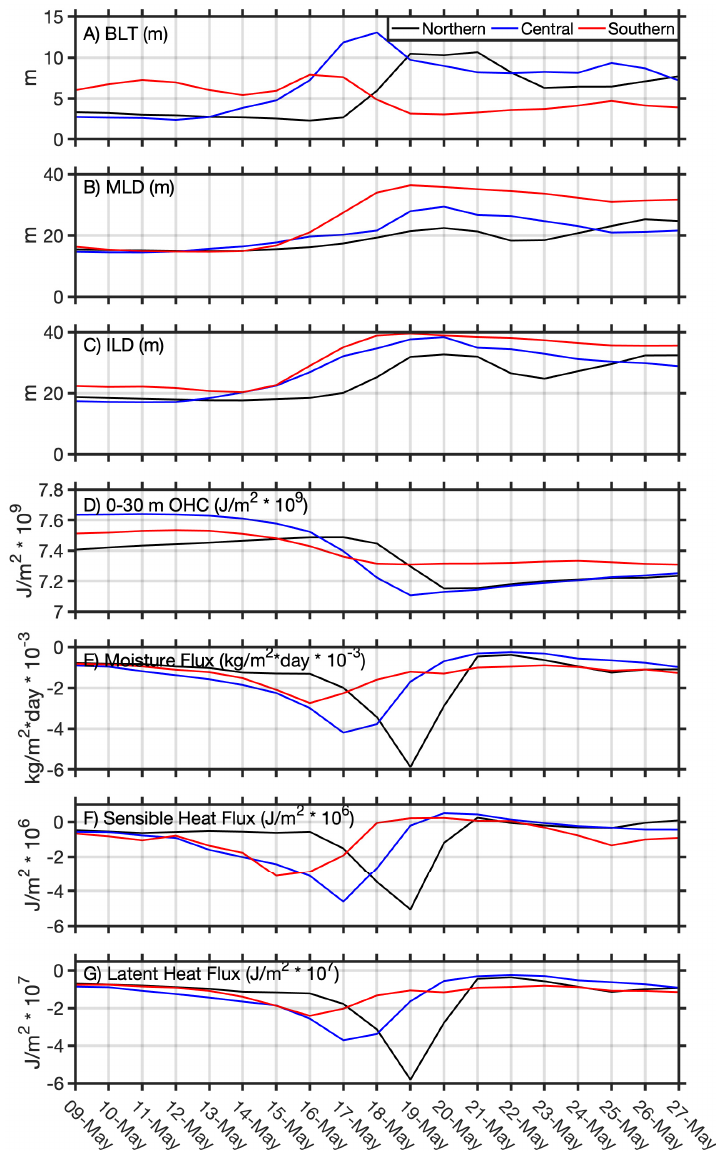
Figure 7. Box-averaged time series from May 9 to May 27, 2020 in the northern (86–88 ◦ E, 15–20 ◦ N; black), central (86–88 ◦ E, 10–15 ◦ N; blue), and southern (86–88 ◦ E, 5–10 ◦ N; red) Bay of Bengal for: ( A ) NEMO-derived BLT (m); ( B ) NEMO-derived MLD (m); ( C ) NEMO-derived ILD (m); ( D ) NEMO-derived 0–30 m OHC (J / m 2 * 10 9 ); ( E ) ERA5 instantaneous moisture flux (kg / m 2 *day*10 − 3 ); ( F ) ERA5 surface sensible heat flux (J / m 2 * 10 6 ); and ( G ) ERA5 surface latent heat flux (J / m 2 * 10 7